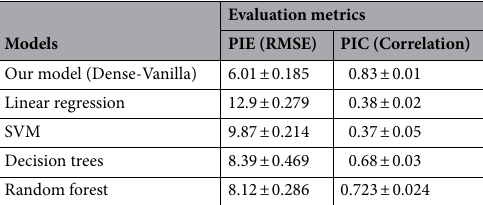
Table 1. Performance comparison between our proposed dense vanilla model and baseline methods.